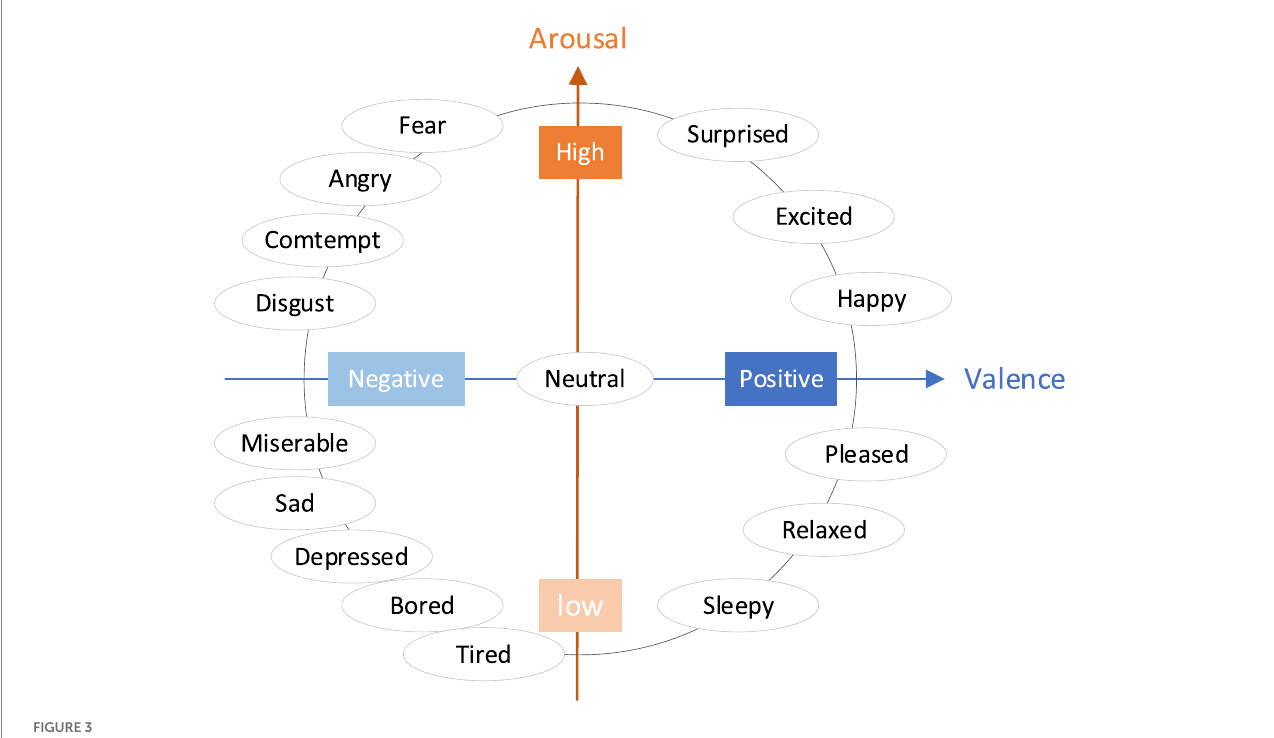
FIGURE 3 Two-dimensional model for valence–arousal.